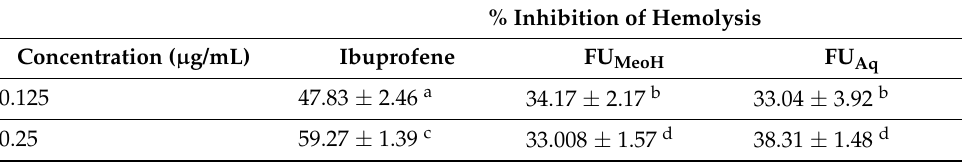
Table 5. Inhibitory effects of ibuprofen and F. umbellatta extracts on hemolysis of erythrocytes